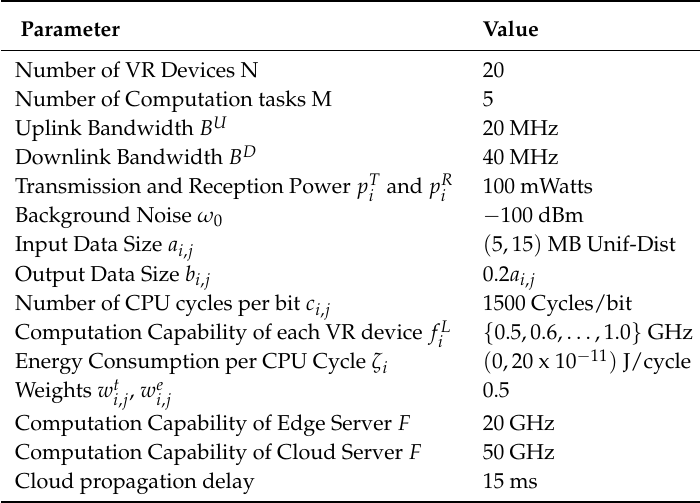
Table 2. Simulation